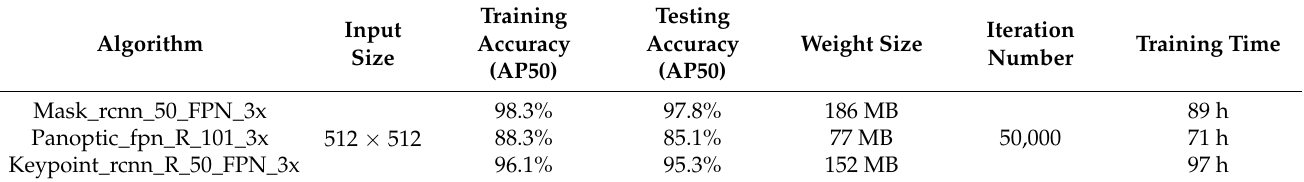
Table 4. Distribution of all fire images in the dataset. Table 5. Pre-trained weights using